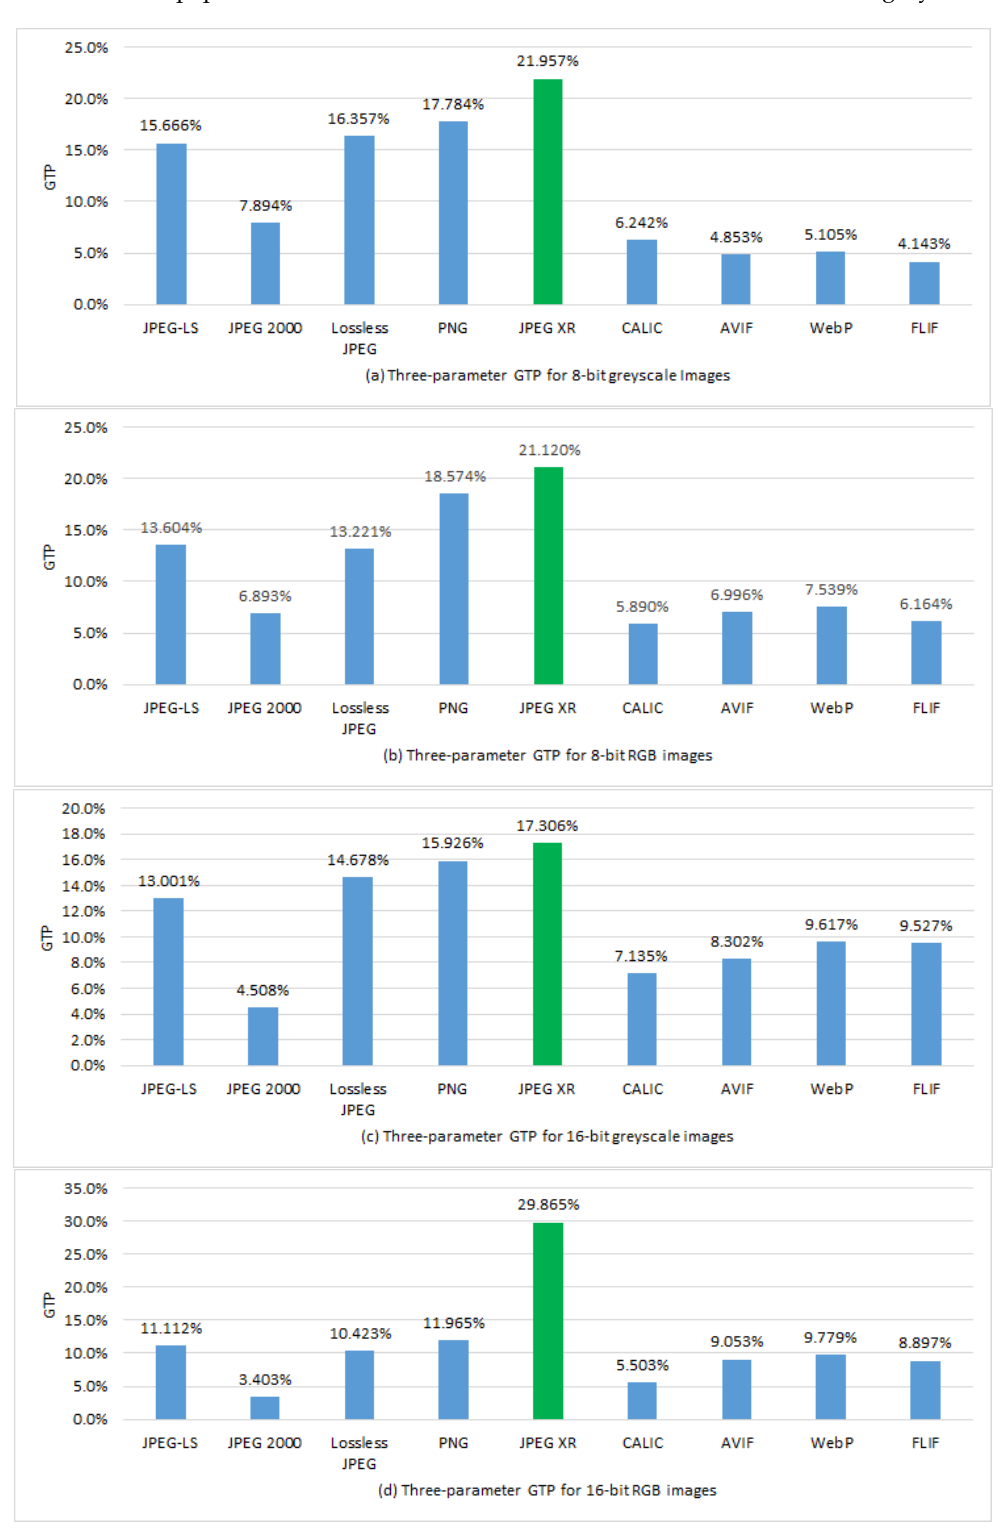
Figure 33. Three-parameter